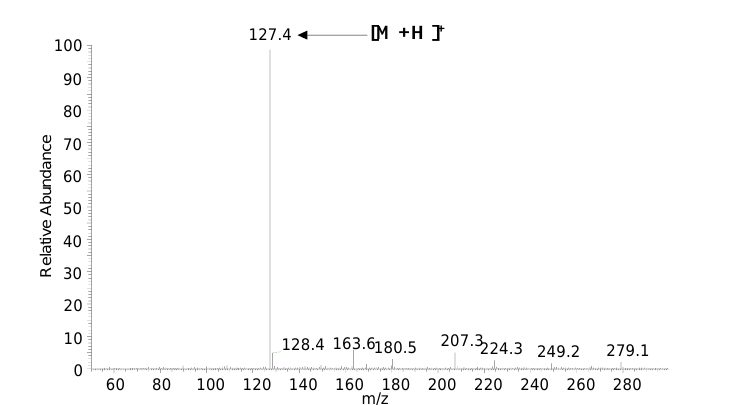
Figure 2. HPLC chromatogram of maltol in red ginseng.